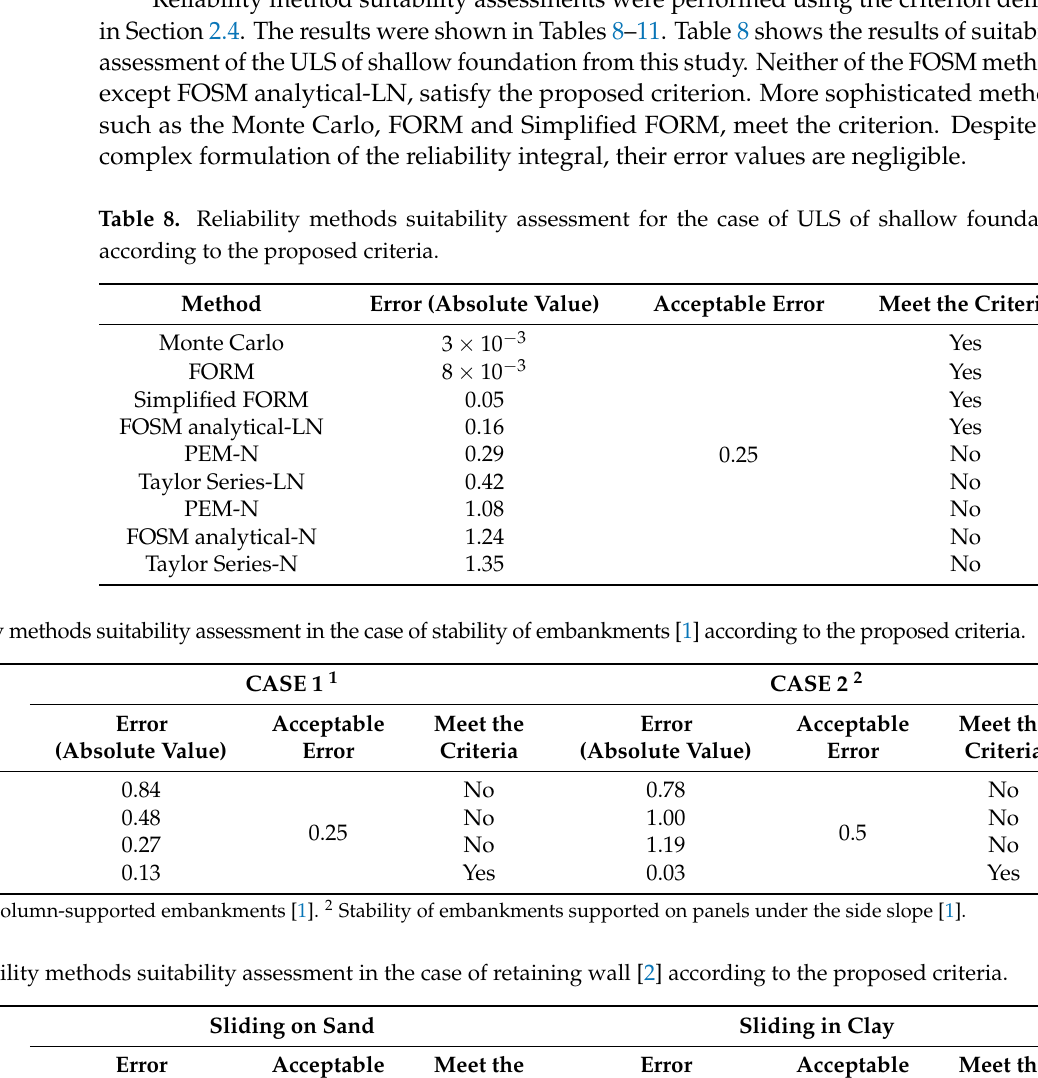
Table 10. Reliability methods suitability assessment in the case of retaining wall [2] according to the proposed criteria.